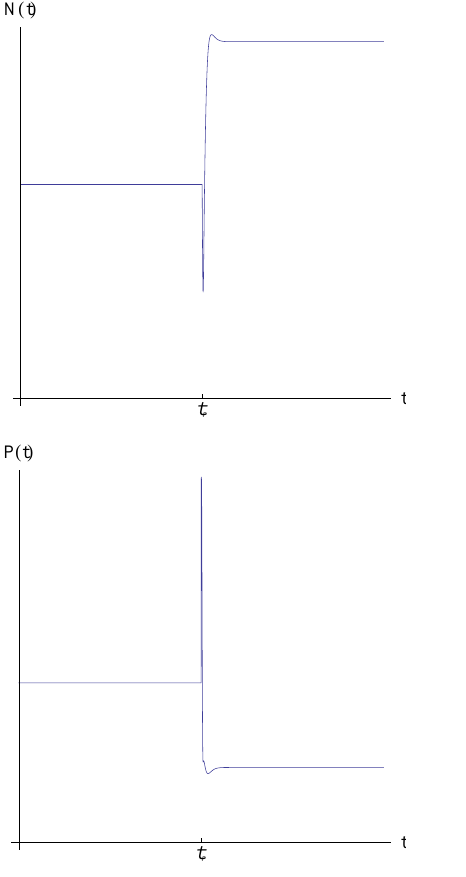
Fig. 17. Stabilization of a predator-prey system after a large perturbation in the case of two stable internal equilibria.